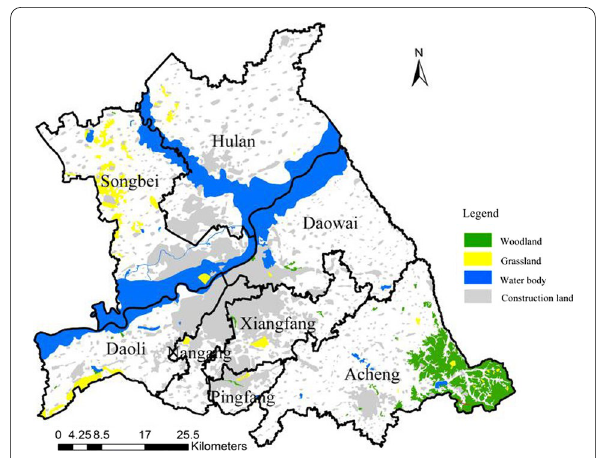
Fig. 3 Ecological sources of the study area